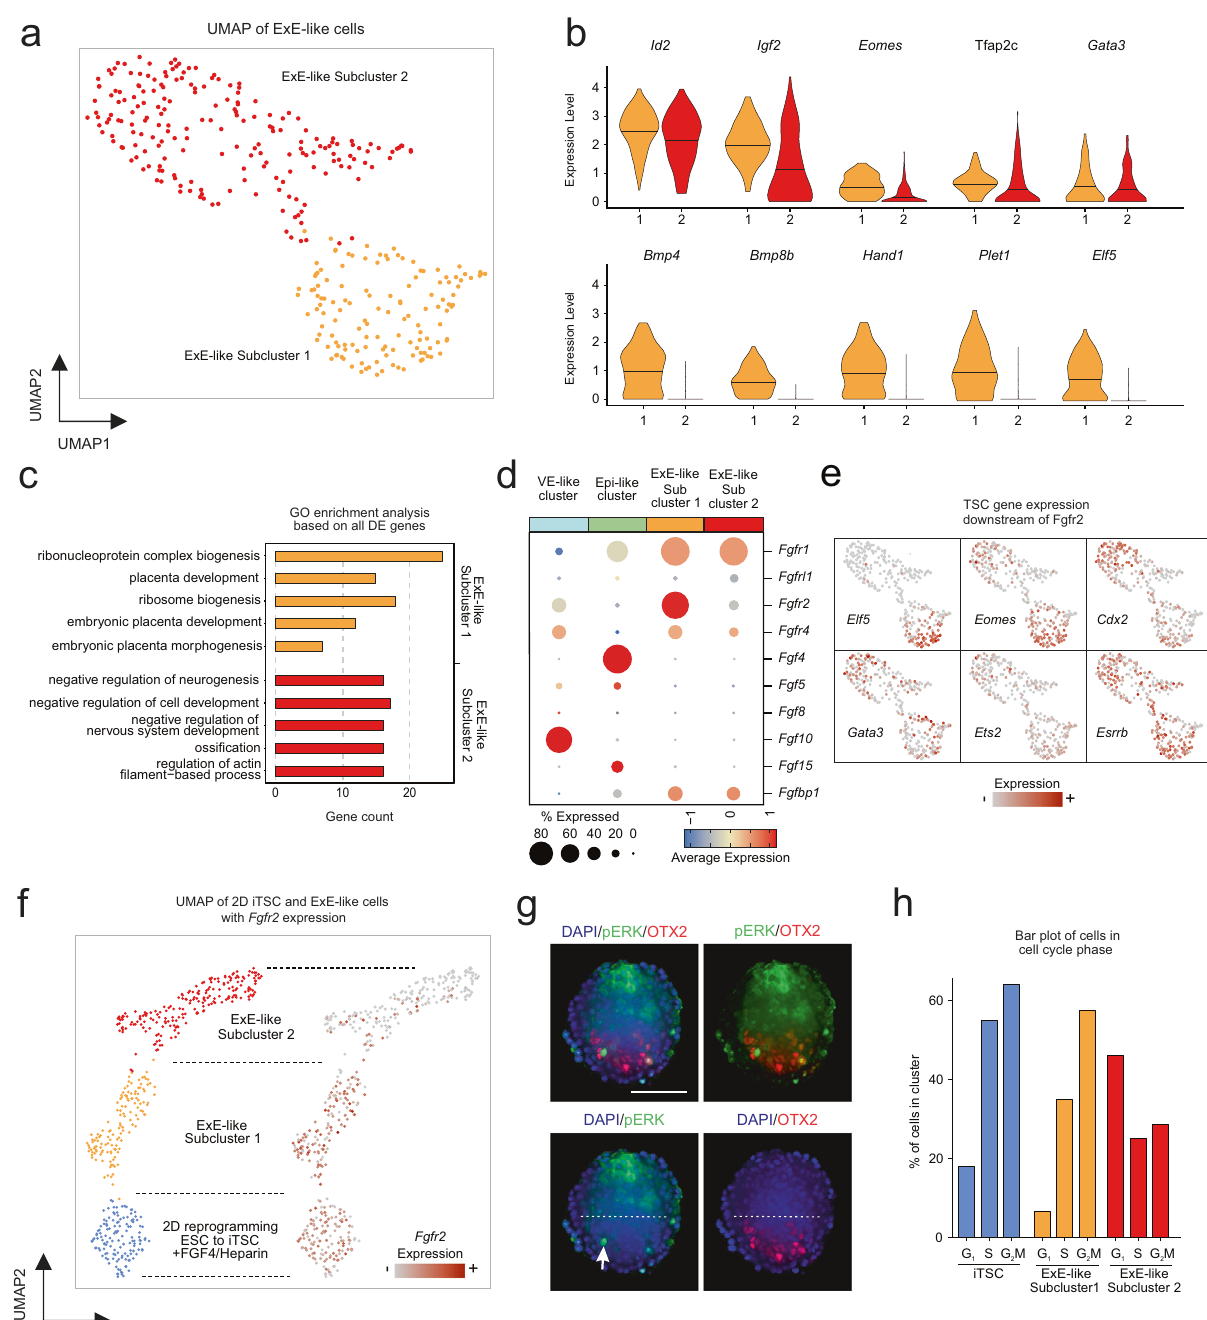
Fig. 5 Bipartite transcriptional character of cells comprising the ExE-like cluster. a UMAP representation reveals two transcriptionally diverging subclusters for the ExE-like cluster. b Violinplots show expression of trophoblast marker genes. The plots display cells with an expression >0 (line represent mean of cells). c GO Term analysis based on all variable genes of each of the ExE-like subclusters, revealed diverging biological functions of the two subcluster. d Dotplot displaying FGF-receptor and ligand expressing cells throughout VE-, Epi-, and ExE-like (Sub)clusters. e Featureplots depicting expression of FGF4 downstream signaling targets within the ExE-like cluster. f UMAP representation including transcriptional pro fi les of iTSCs obtained from reprogramming in FGF4/Heparin supplemented 2D mono-culture, shows close clustering of iTSCs and ExE-like Subcluster 1, both of which display high expression of the FGF4 receptor Fgfr2 . g IF staining against pERK showed most intense pERK activity in the distal part of the ExE-like compartment. Scale bar = 100 µ m; White arrow indicates pERK + cell in Epi-like compartment; Dotted lines represents border of Epi- and ExE-like compartments. OTX2, red; pERK, green; DAPI, blue. h Bar plots displaying distribution of cell cycle phases in ExE-like Subcluster 1, 2 and iTSCs, as assessed by Nestorowa et al. 65 , con fi rming stem cell characteristics of ExE-like Subcluster 1 and differentiating character of ExE-like Subcluster 2. Experiments were repeated independently at least three times with similar results ( g